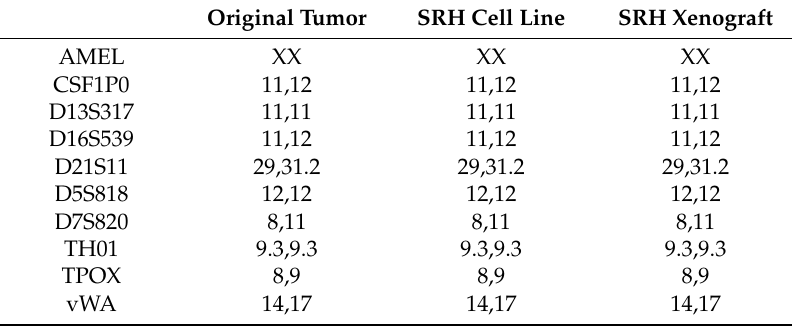
Table 2. Cell line authentication based on short tandem repeat (STR)